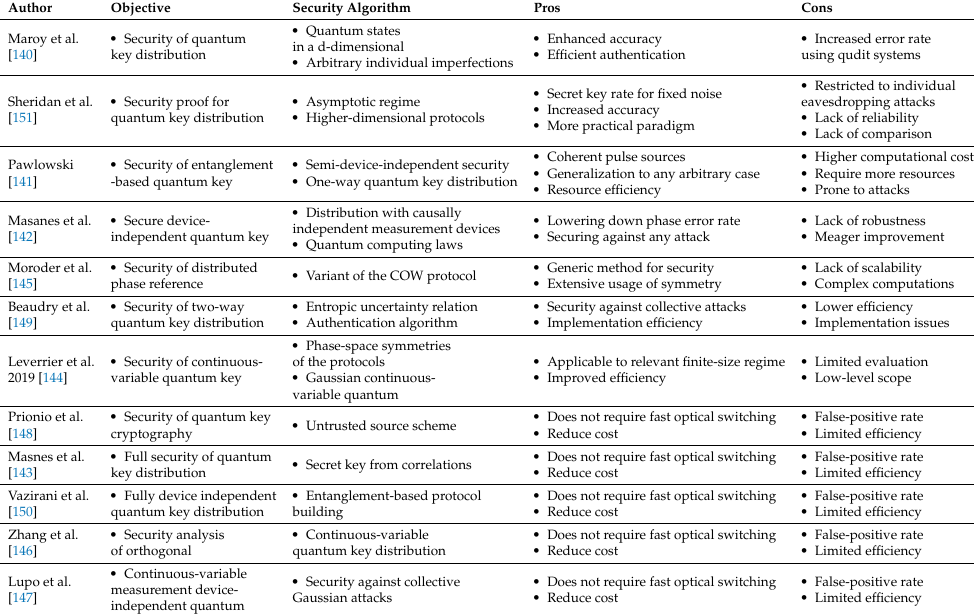
Table 6. Summary of countermeasures and security protocols for general security risks .